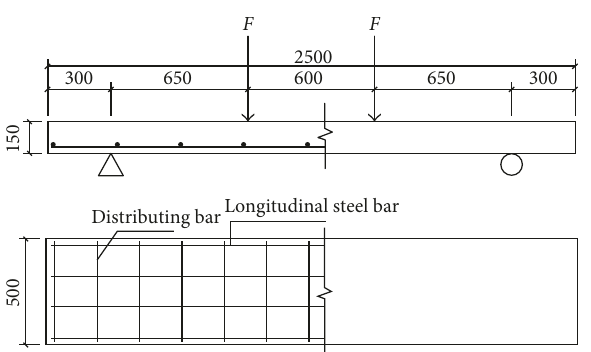
Figure 1: Reinforcement of specimens.